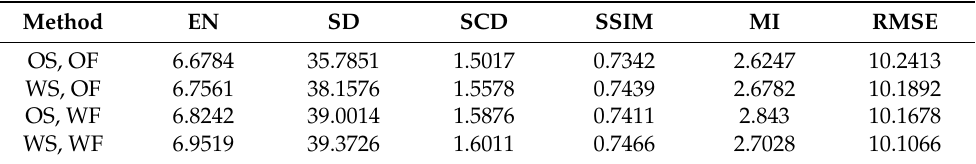
Table 3. Objective evaluation of outputs of with focal self-attention and self-adaptive fusion strategy (WS, WF), with focal self-attention and without self-adaptive fusion strategy (WS, OF), without focal self-attention and with self-adaptive fusion strategy (OS, WF) and without focal self-attention and self-adaptive fusion strategy (OS, OF) on TNO